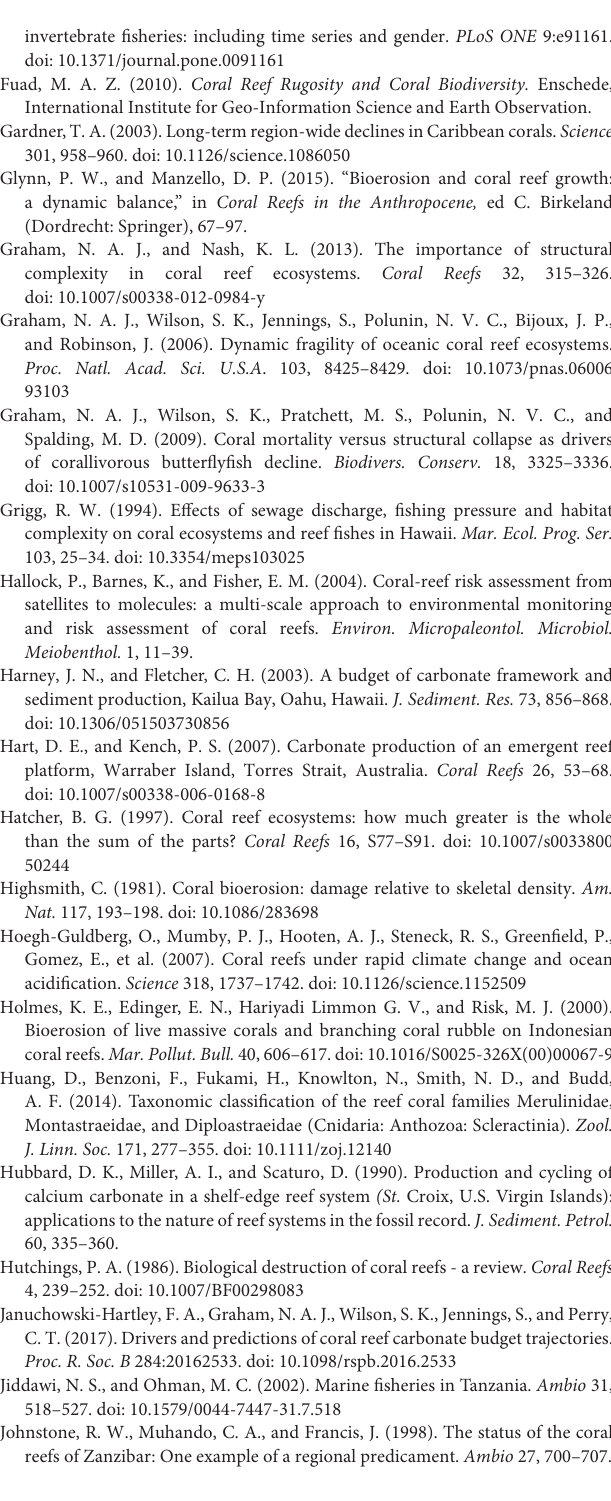
Figure S2 | Bioerosion by encrustation and excavation of an aggressive and unclassified boring sponge on a massive coral at Prison Reef. Figure S3 | Collapse and fall of large coral colonies at Prison